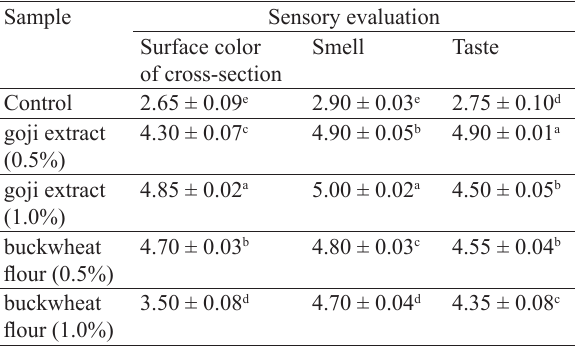
Table 1 Sensory evaluation of the taste, aroma, and surface color of the cross-section of vacuum-packaged samples after 21 days of storage at 0–4°C Sample Sensory evaluation